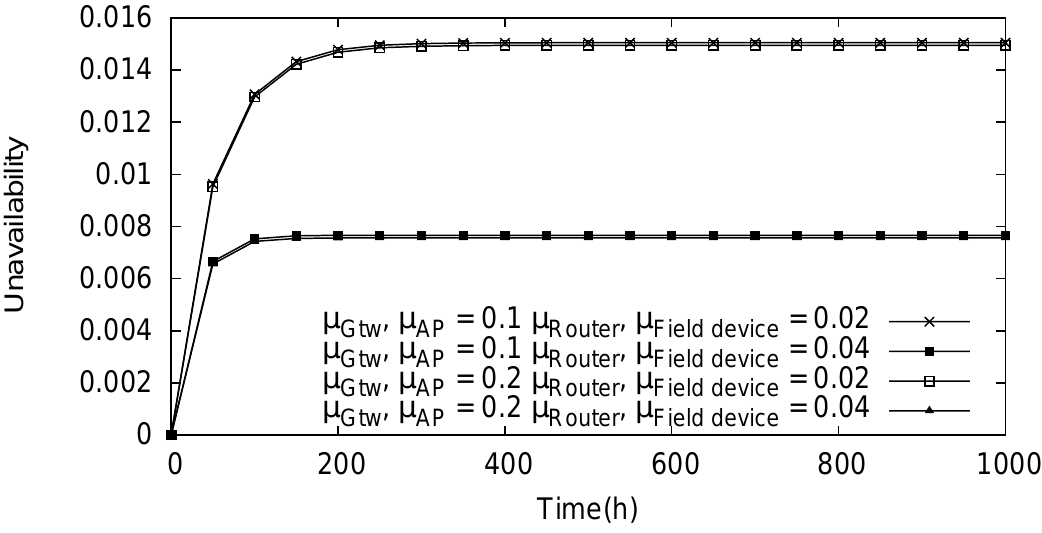
Figure 21. Influence of the maintenance of devices in the network